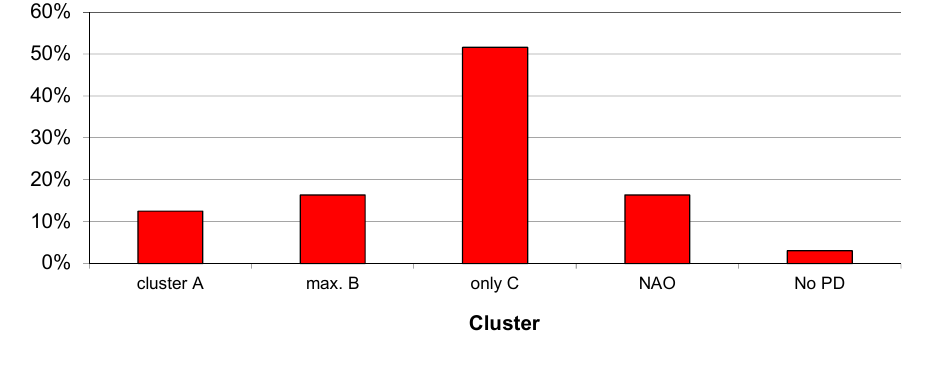
Figure 1: Percentage with paid